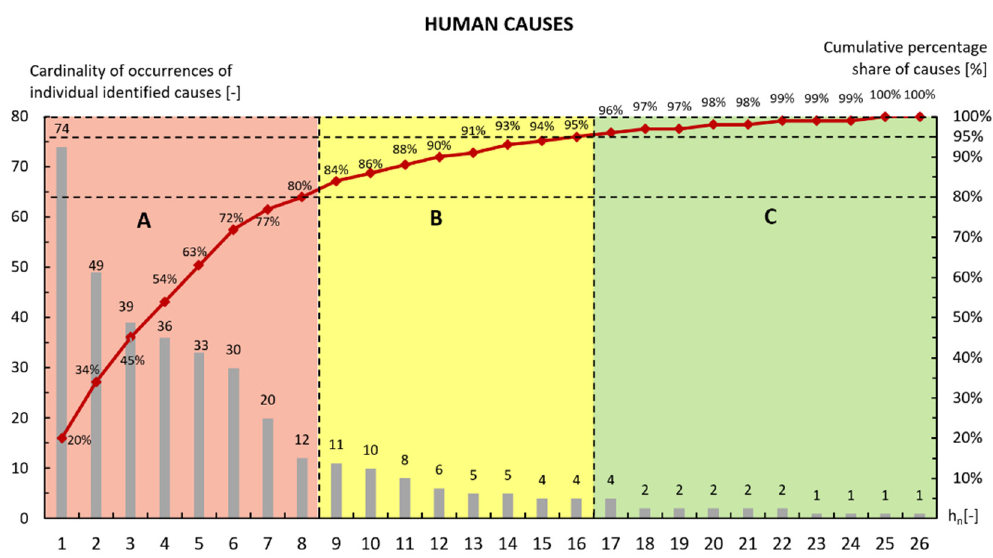
Figure 4. Pareto-Lorenz chart of the identified human causes.